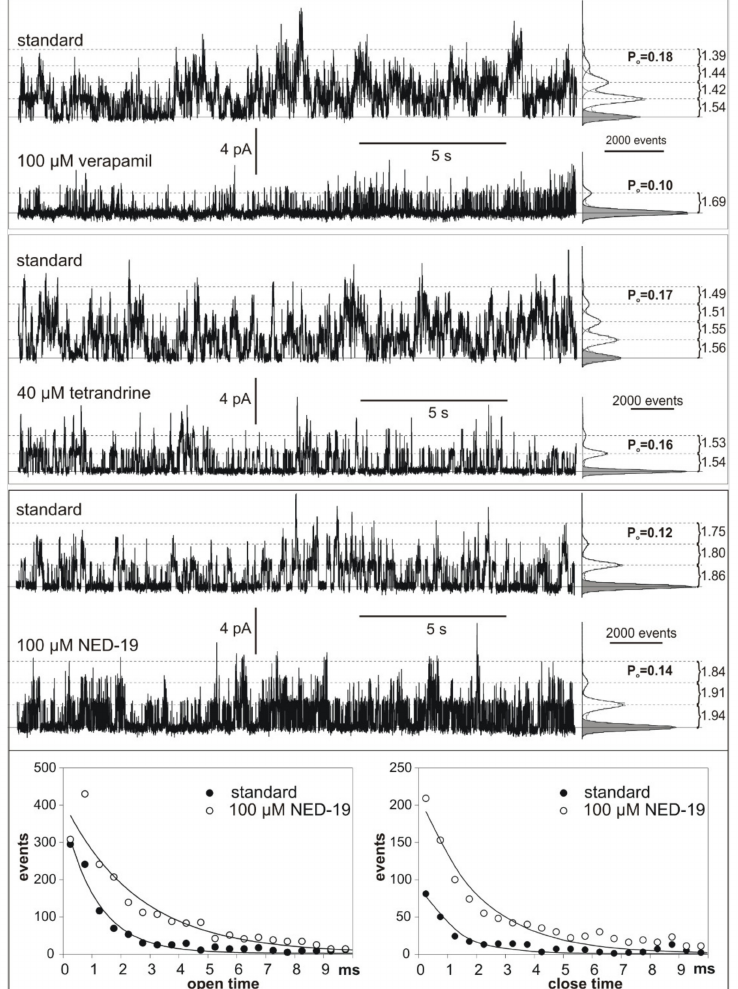
Figure 5. Comparison of SV/TPC channel activity recorded after the application of 100 µ M verapamil, 40 µ M tetrandrine, and 100 µ M NED-19. The traces were obtained at 60 mV. The solid line and grey histograms indicate the closed state, and the dashed line and white histograms indicate open states. Amplitudes of the currents flowing through the single channels and open probabilities (P o ) obtained from the histograms are indicated. The measurements were prepared in the cytoplasm- out